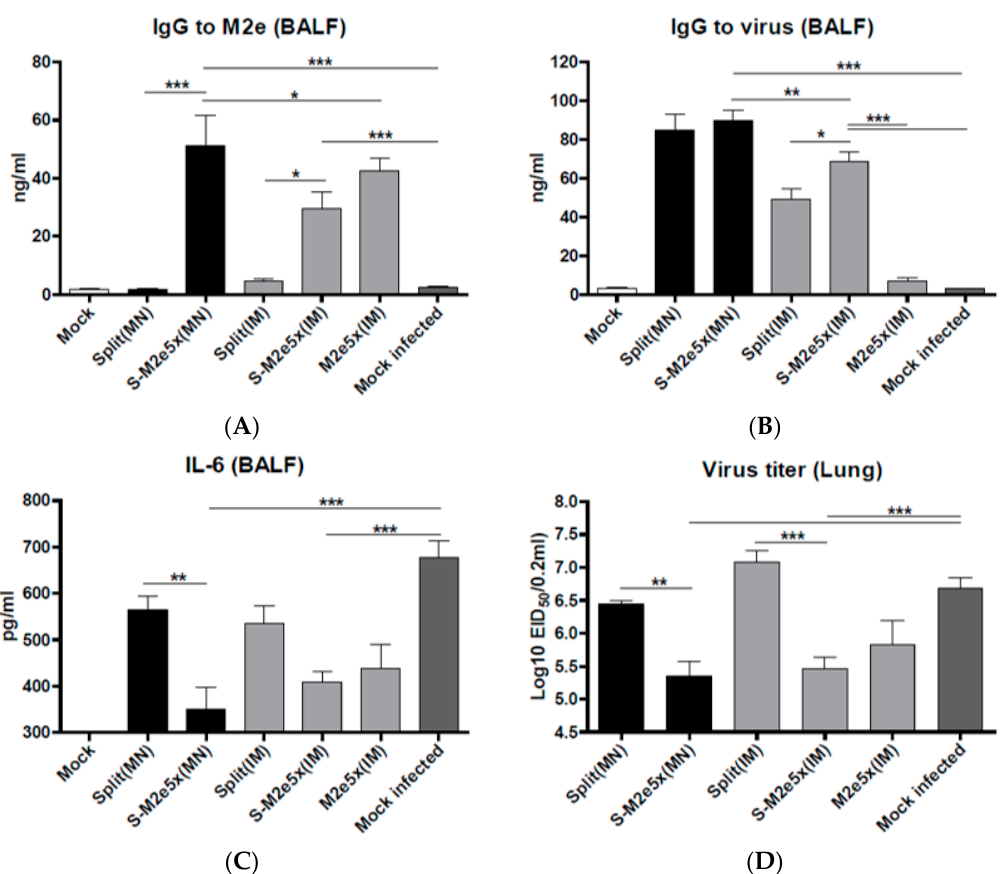
Figure 6. M2e-specific IgG antibodies, inflammatory IL-6 cytokine, and lung viral titers. Levels of IgG antibodies and cytokines in bronchoalveolar lavage fluids (BALF) samples collected from mice were determined at day 4 post-challenge ( N = 4) at 8 weeks after boost vaccination. ( A ) IgG antibody level to A / California / 04 / 09 (H1N1) virus. ( B ) M2e specific IgG antibody responses to M2e peptide. IgG antibody responses were determined by ELISA using inactivated influenza virus (A / Cal) or human type M2e peptide as a coating antigen (4 ug / mL). ( C ) Inflammatory IL-6 cytokine in BALF. IL-6 was determined by a cytokine ELISA ( N = 4). ( D ) Lung viral titers. Lung viral titers were determined by an egg inoculation assay day 4 post challenge ( N = 4). Error bars indicate mean ± SEM. BALF, bronchoalveolar lavage fluid; pg, picogram. MN: skin immunization by MN patch, IM: intramuscular needle injection immunization. One-way ANOVA and Tukey’s post-multiple comparison test were performed. *; p < 0.05, **; p < 0.01, ***; p < 0.001 between the marked groups.